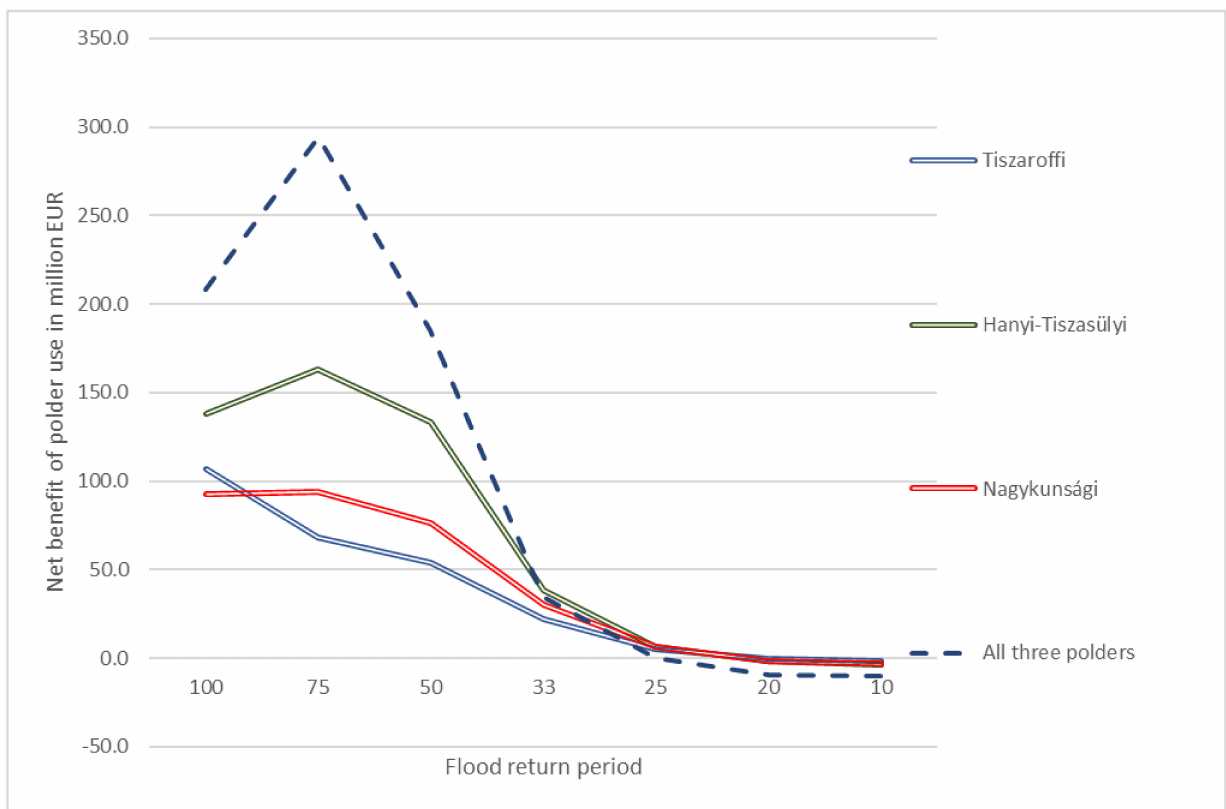
Figure 2. Middle Tisza flood peak polders’ net benefit over different return period flood events. Source: Raw data of the figure with permission from [20].